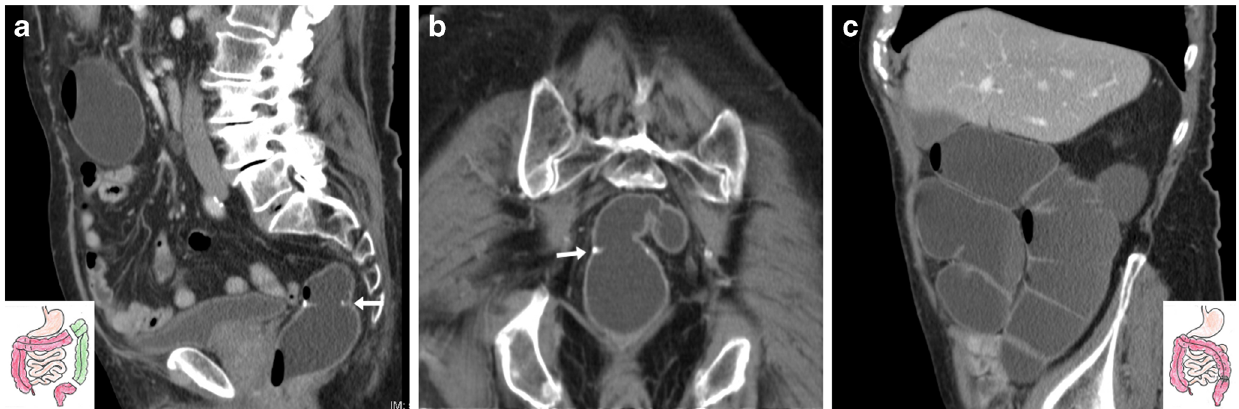
Fig. 3 Expected status after left hemicolectomy (surgical scheme shown in insets) for carcinoma in an 86-year-old male with impassable anastomosis. Multiplanar WE-MDCT images ( a – c ) showed a normally